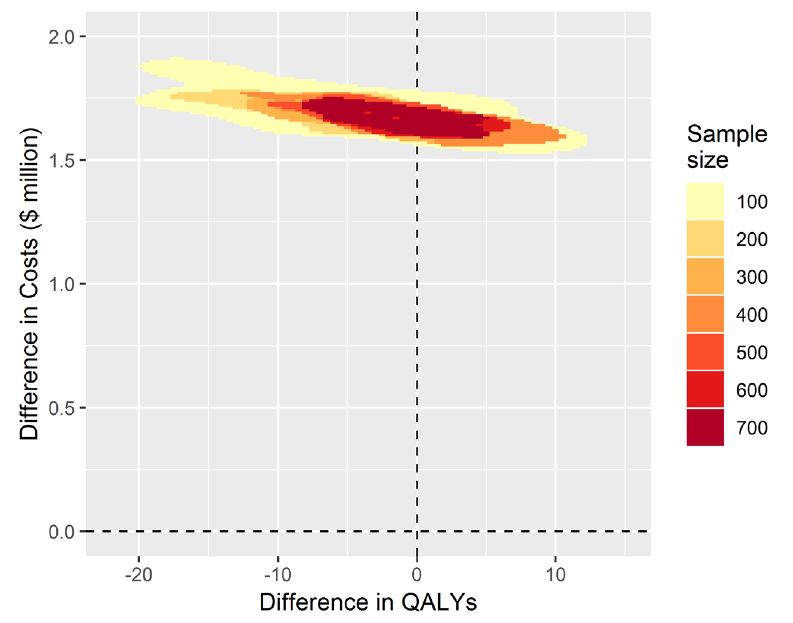
Figure 3. The conclusion for decision-making is clear when there is no treatment effect, costs are increased for no change to health benefits for all sample